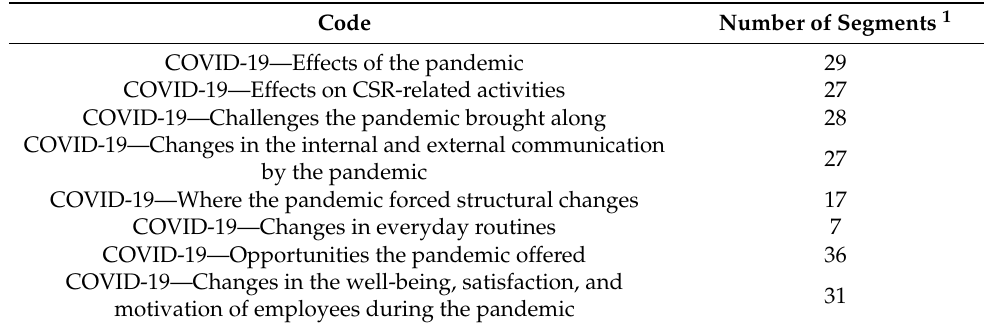
Table 3. Codes and the respective number of related